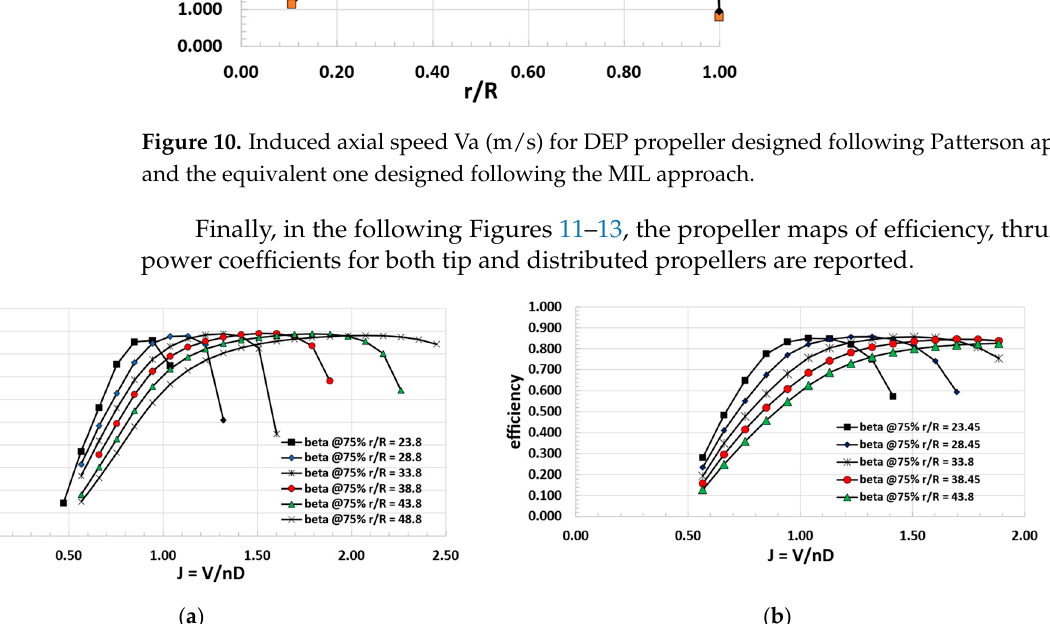
( b ) Figure 12. Propellers thrust coefficient map (different blade pitch angles). ( a ) Tip propeller. ( b ) DEP propeller. ( a ) ( b ) Figure 13. Propeller power coefficient map (different blade pitch angles). ( a ) Tip propeller. ( b ) DEP propeller. 2.3. Flap Settings Design In order to estimate low-speed performance, it was necessary to design the flap settings. As for propeller design, the starting point for the flap design was the indications coming from the preliminary design phase performed during the ELICA project. Indeed, in that design phase, to obtain a certain lift gain in low-speed conditions (take-off and landing), the extension in chord, span, and flap deflections were estimated by means of semi-empirical methods. A single-slotted Fowler flap was assumed (see Table 9).